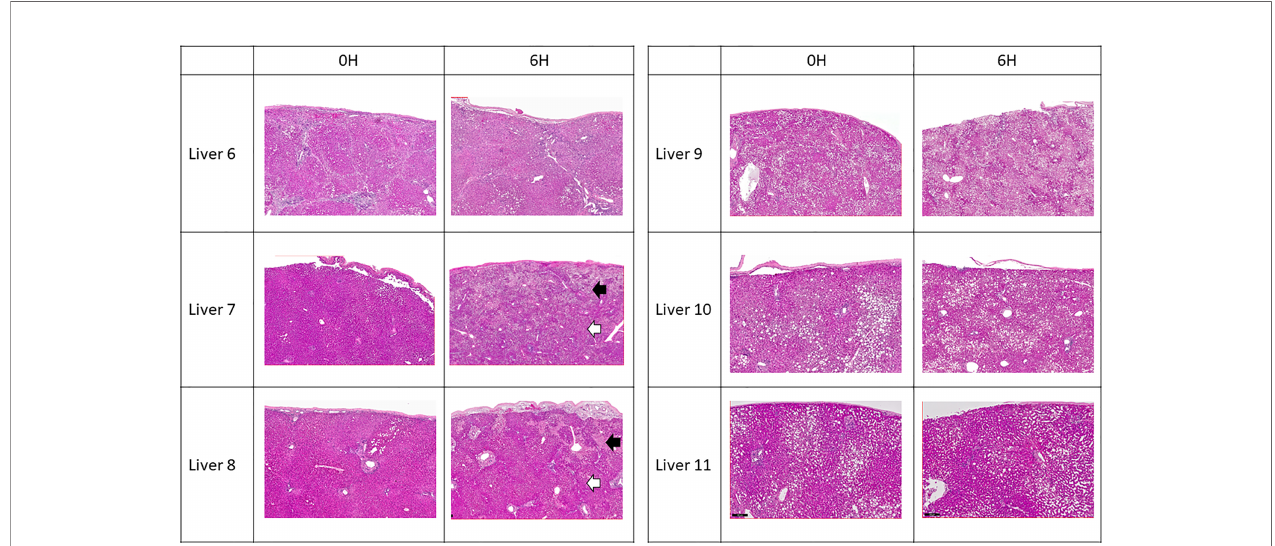
FIGURE 4 | Representative H & E histology of liver tissue. Liver 6 exhibited cirrhotic change. Livers 9, 10 and 11 exhibited variable degree of microsteatotic change. At the end of perfusion, histology from livers 6, 9, 10, and 11 showed completely viable tissue with no structural change. Livers 7 and 8 exhibited